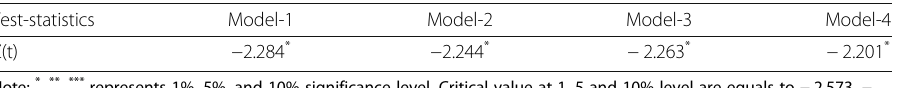
Table 5 Engle-Granger cointegration estimates